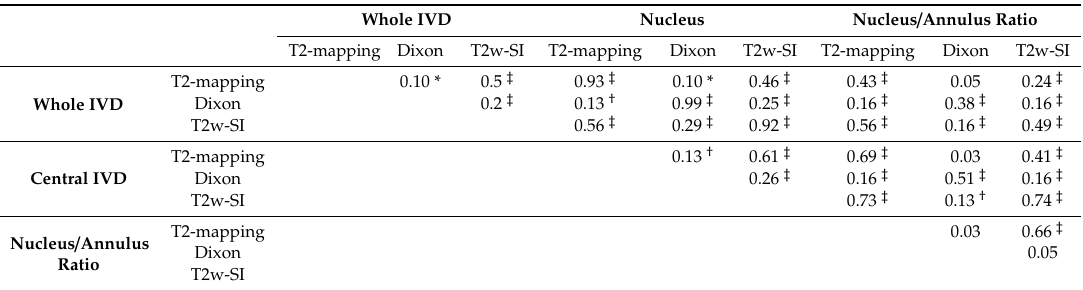
Table 3. Quantification of the IVD by T2-mapping correlated moderately with T2w-SI and weakly with